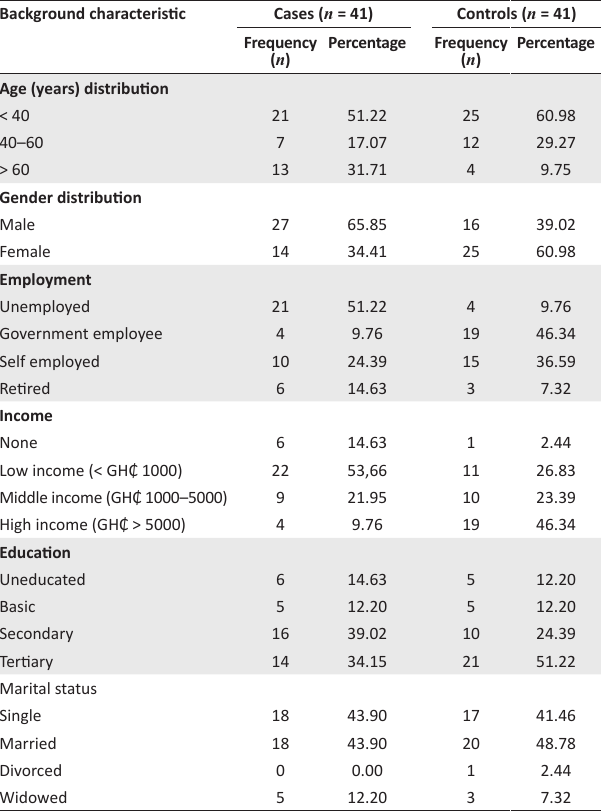
TABLE 1: Demographic profile of studied subjects ( n = 82). Background characteristic